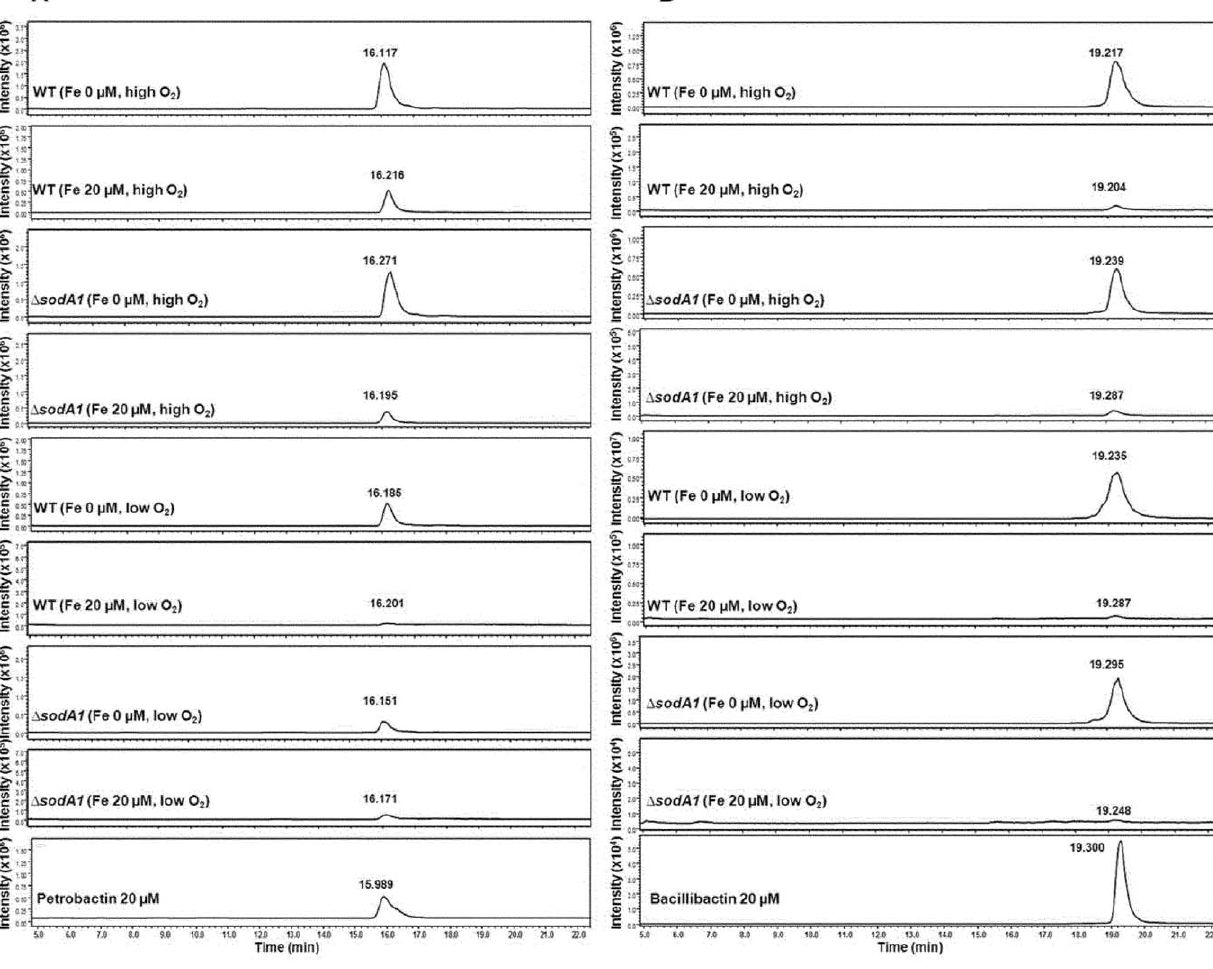
Figure 4. LCMS profiles of petrobactin and bacillibactin from the extracts of the IDM cultures of B.anthracis with or without addition of iron under high and low aeration. (A) SIM chromatogram of petrobactin at the mass range of m/z 719.3 [M + H] + . The peaks at 15.989– 16.271 min represent petrobactin. (B) SIM chromatogram of bacillibactin at the mass range of m/z 883.2 [M + H] + . The peaks at 19.204–19.300 min represent bacillibactin.